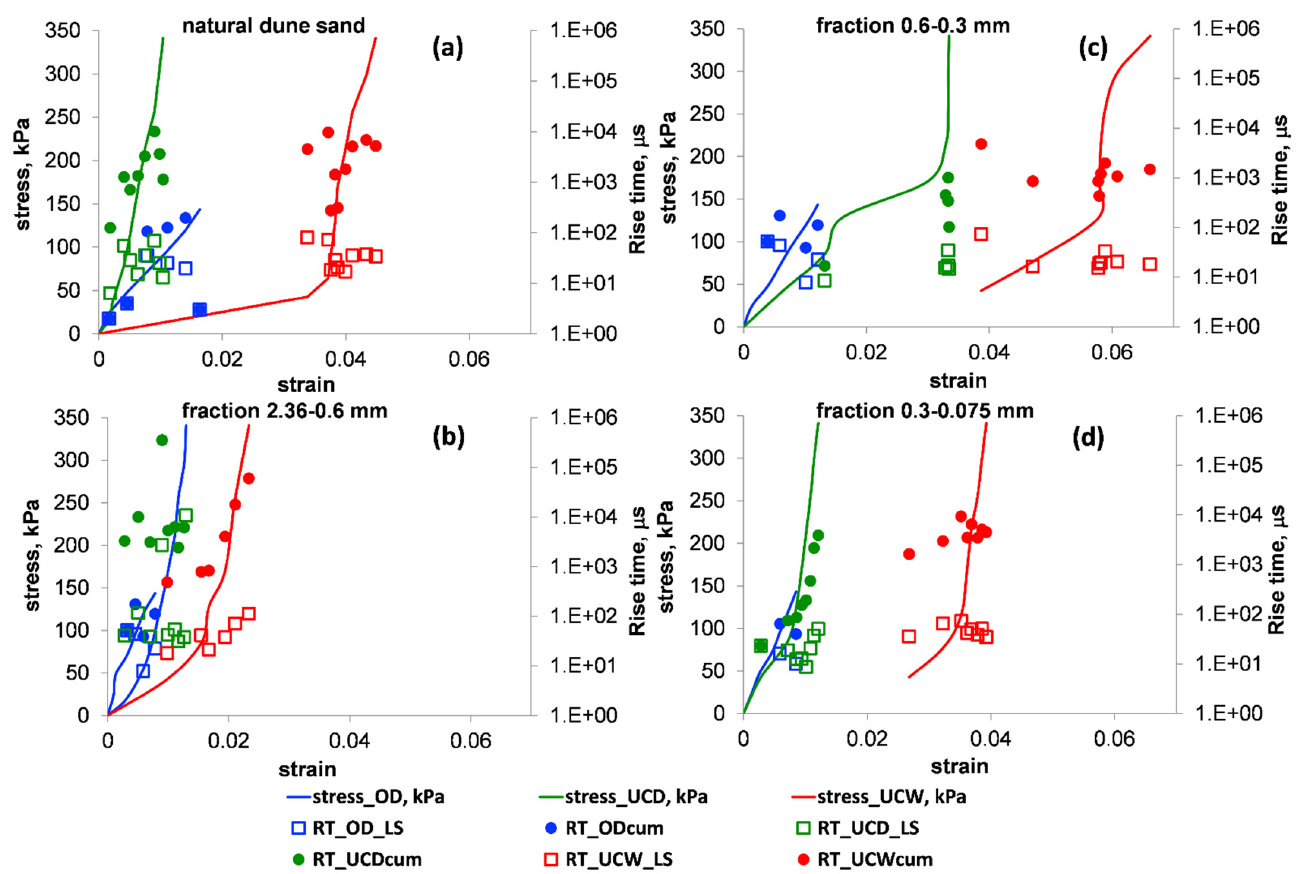
Figure 8. The stress–strain relationships (solid curves) vs. the values of the rise time (RT) for the OD (blue), UCD (green) and UCW (red) tests. The empty squares and the full circles denote the values of average (index = LS) and cumulative (index = cum) RTs for a loading stage, respectively. Panels ( a – d ) present the results for natural dune sand and its three extracted fractions: 2.36–0.6, 0.6–0.3 and 0.3–0.075 mm, respectively. Note that in the used number format, the notation “E ± xx” is part of a scientific notation and corresponds to “ · 10 ± xx